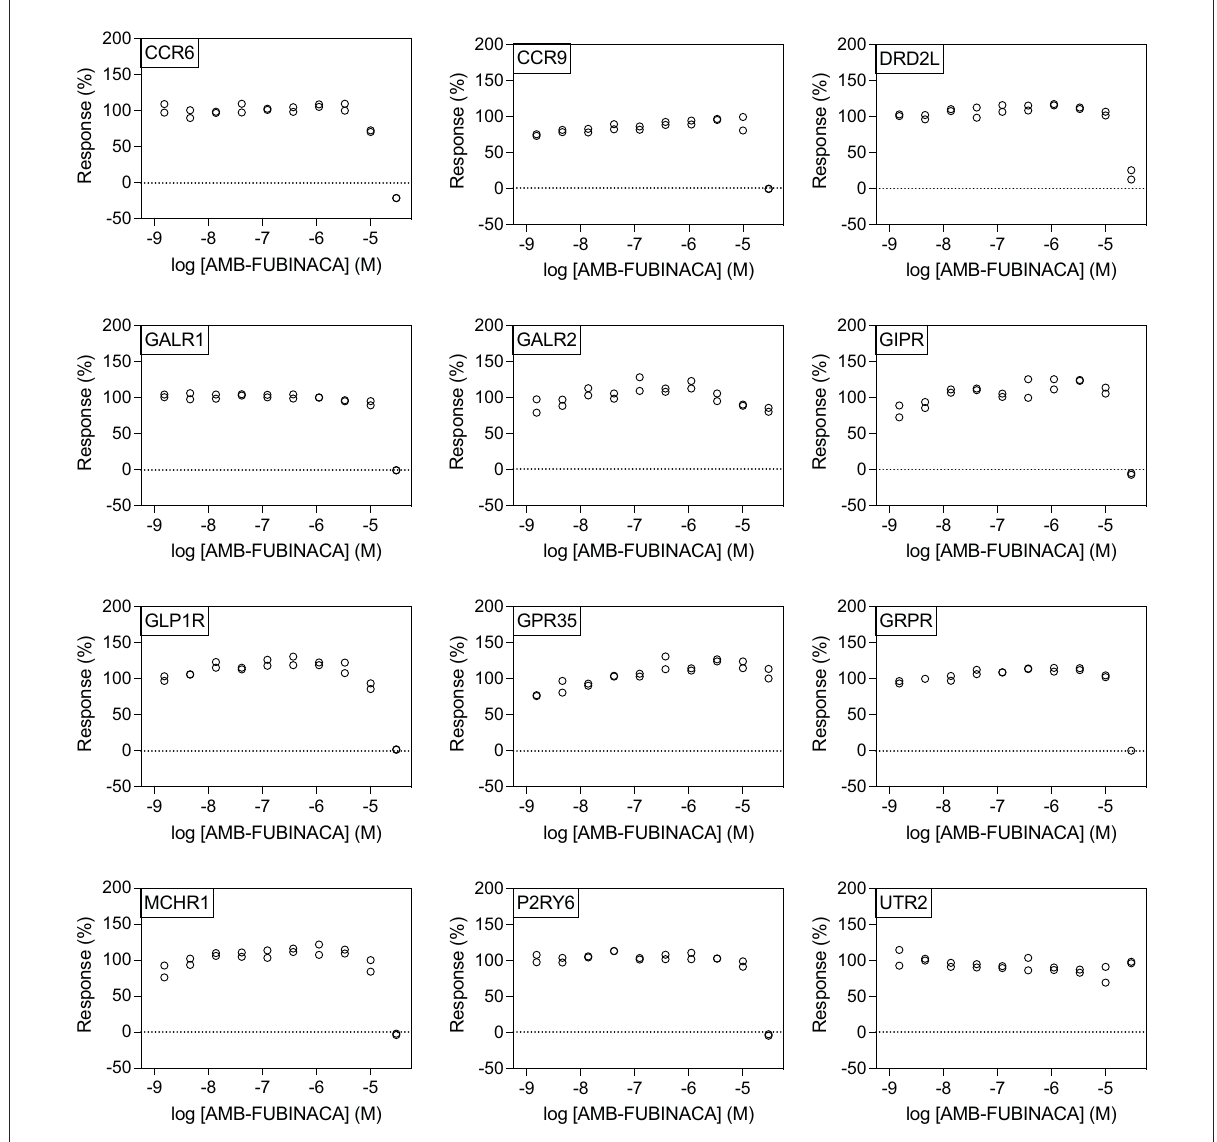
FIGURE5 AMB-FUBINACA does not promote potent inhibition of β -arrestin recruitment in 12 GPCRs. IC 50 of AMB-FUBINACA against each target (listed in the upper left corner of each panel) with EC 80 agonist could not be determined using concentrations up to 30 µ